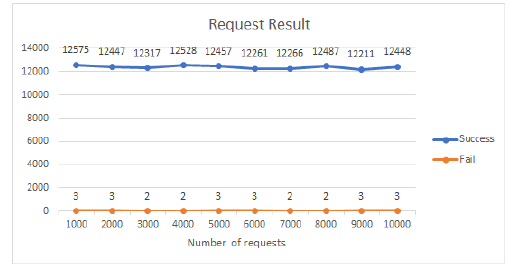
Figure 4. The results of the create data